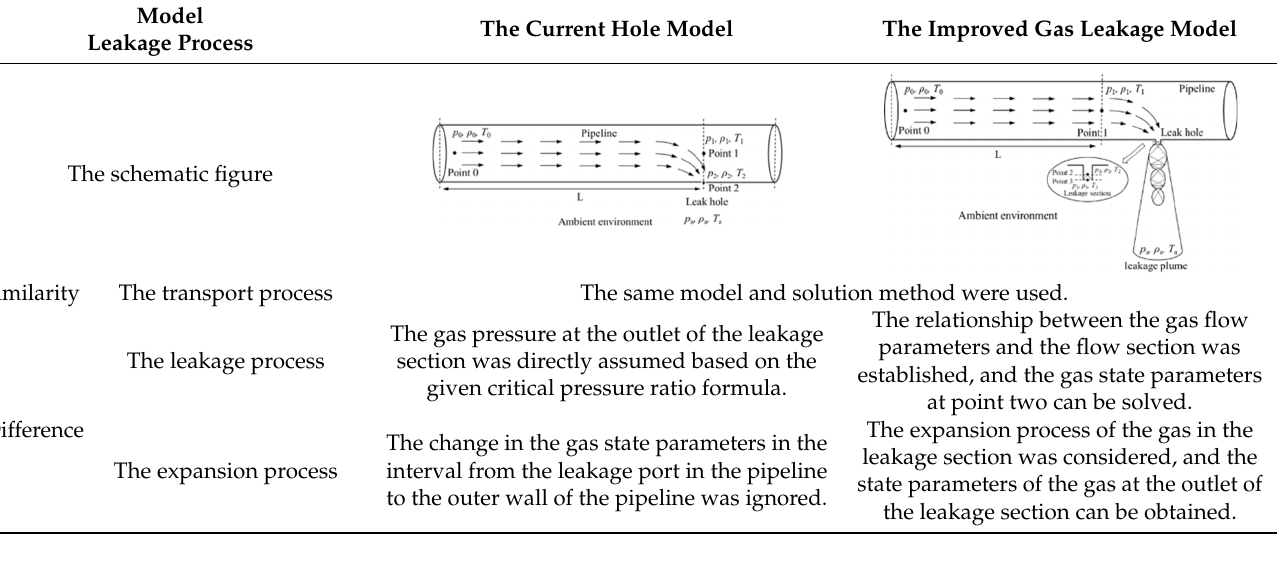
Table 1. Comparison of the current hole model and the improved leakage model.